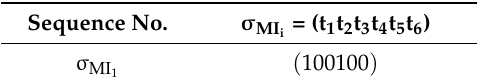
Table 3. Forbidden sequences of Example 1.